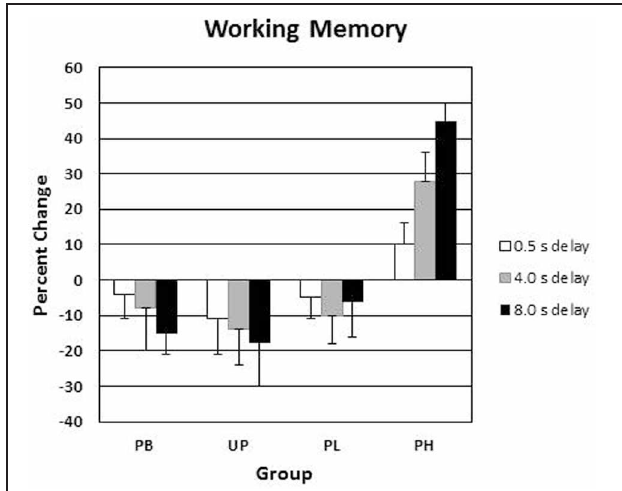
FIGURE 5 | Conditioned contextual facilitation of visuospatial working memory during the Association phase for four experimental groups. Shown is the degree of contextual facilitation (% change from Association day 1 to Test day 4) of visuospatial working memory induced by the general context of Lab A in the Association phase. PB, placebo; UP, unpaired; PL, paired low extraverts; PH, paired high